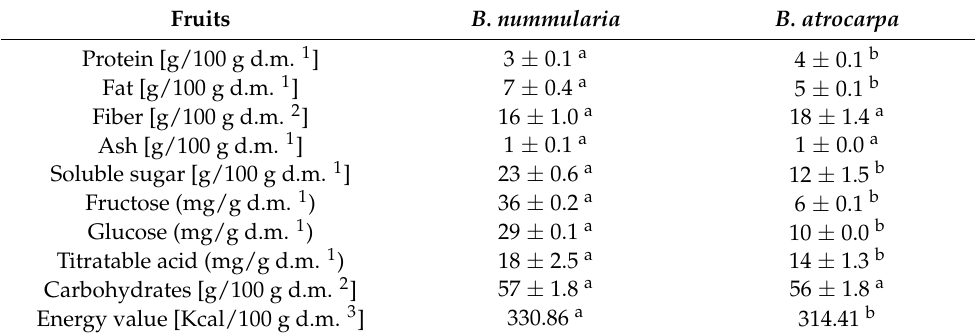
Table 1. Nutritional constituents of B. nummularia and B. atrocarpa fruits. Fruits B. nummularia B. atrocarpa Protein [g/100 g d.m. 1 ] 3 ± 0.1 a 4 ± 0.1 b Fat [g/100 g d.m. 1 ] 7 ± 0.4 a 5 ± 0.1 b Fiber [g/100 g d.m. 2 ] 16 ± 1.0 a 18 ± 1.4 a Ash [g/100 g d.m. 1 ] 1 ± 0.1 a 1 ± 0.0 a Soluble sugar [g/100 g d.m. 1 ] 23 ± 0.6 a 12 ± 1.5 b Fructose (mg/g d.m. 1 ) 36 ± 0.2 a 6 ± 0.1 b Glucose (mg/g d.m. 1 ) 29 ± 0.1 a 10 ± 0.0 b Titratable acid (mg/g d.m. 1 ) 18 ± 2.5 a 14 ± 1.3 b Carbohydrates [g/100 g d.m. 2 ] 57 ± 1.8 a 56 ± 1.8 a Energy value [Kcal/100 g d.m. 3 ] 330.86 a 314.41